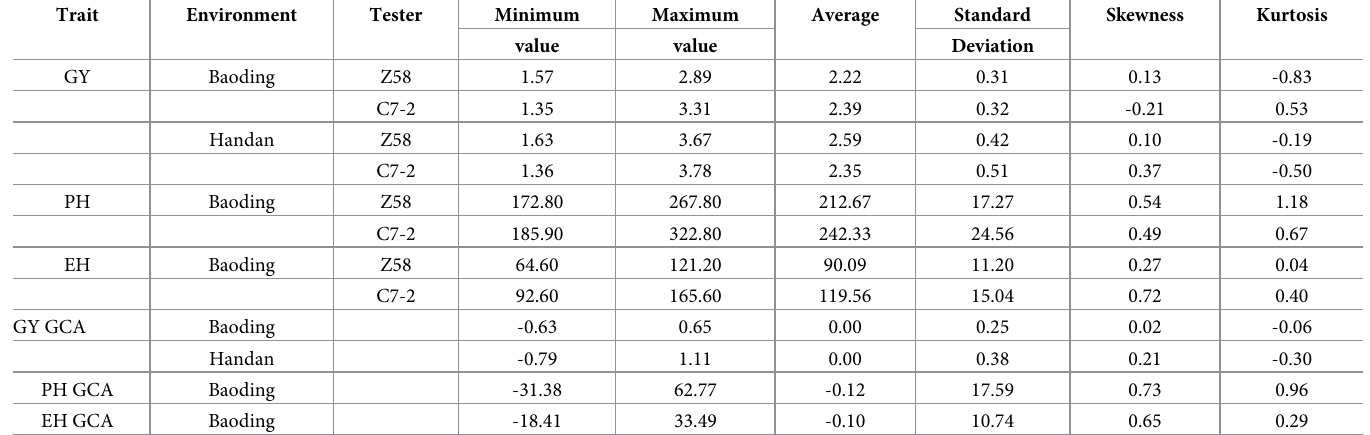
Table 1. Statistic summary of yield-related traits and GCA. Trait